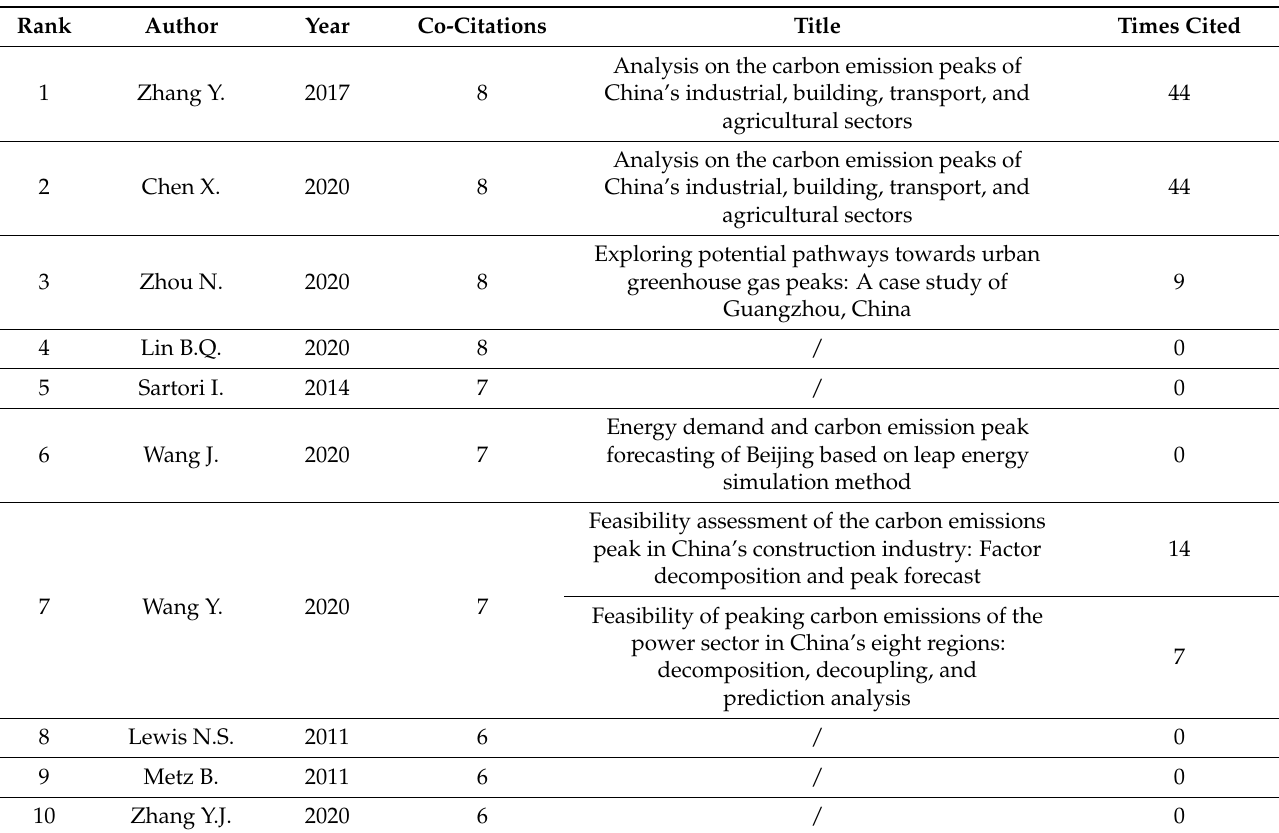
Table 10. Top 10 most co-cited